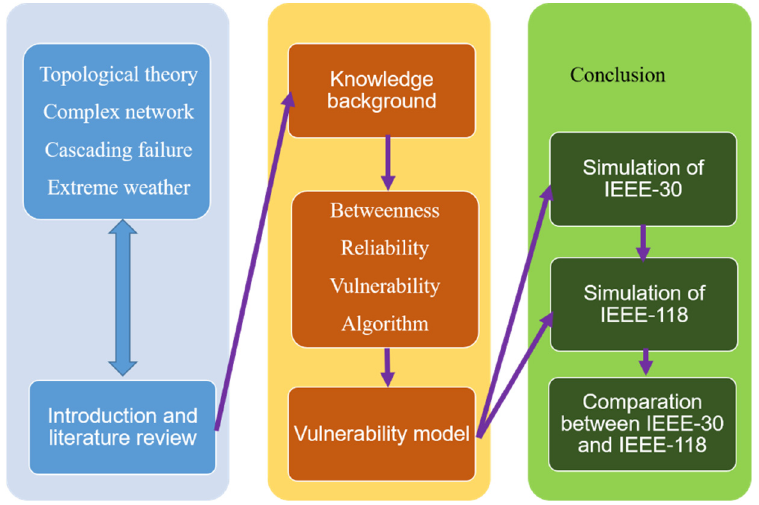
Figure 2. Structure flowchart of this